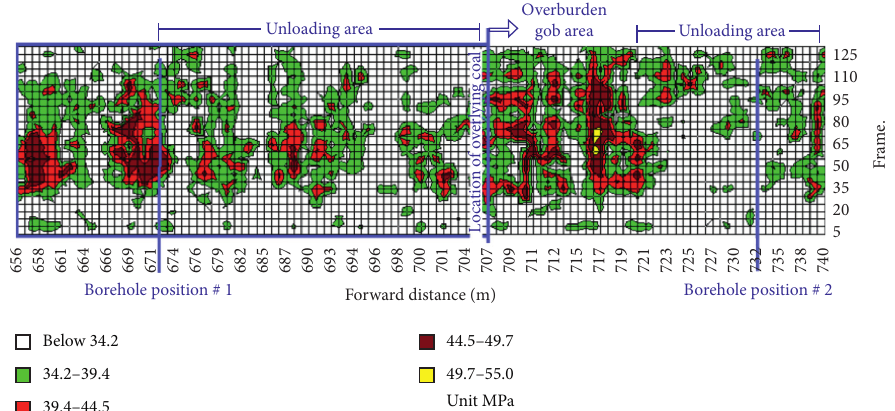
Figure 21: Strata behavior of the 31305 face passing through the overlying coal